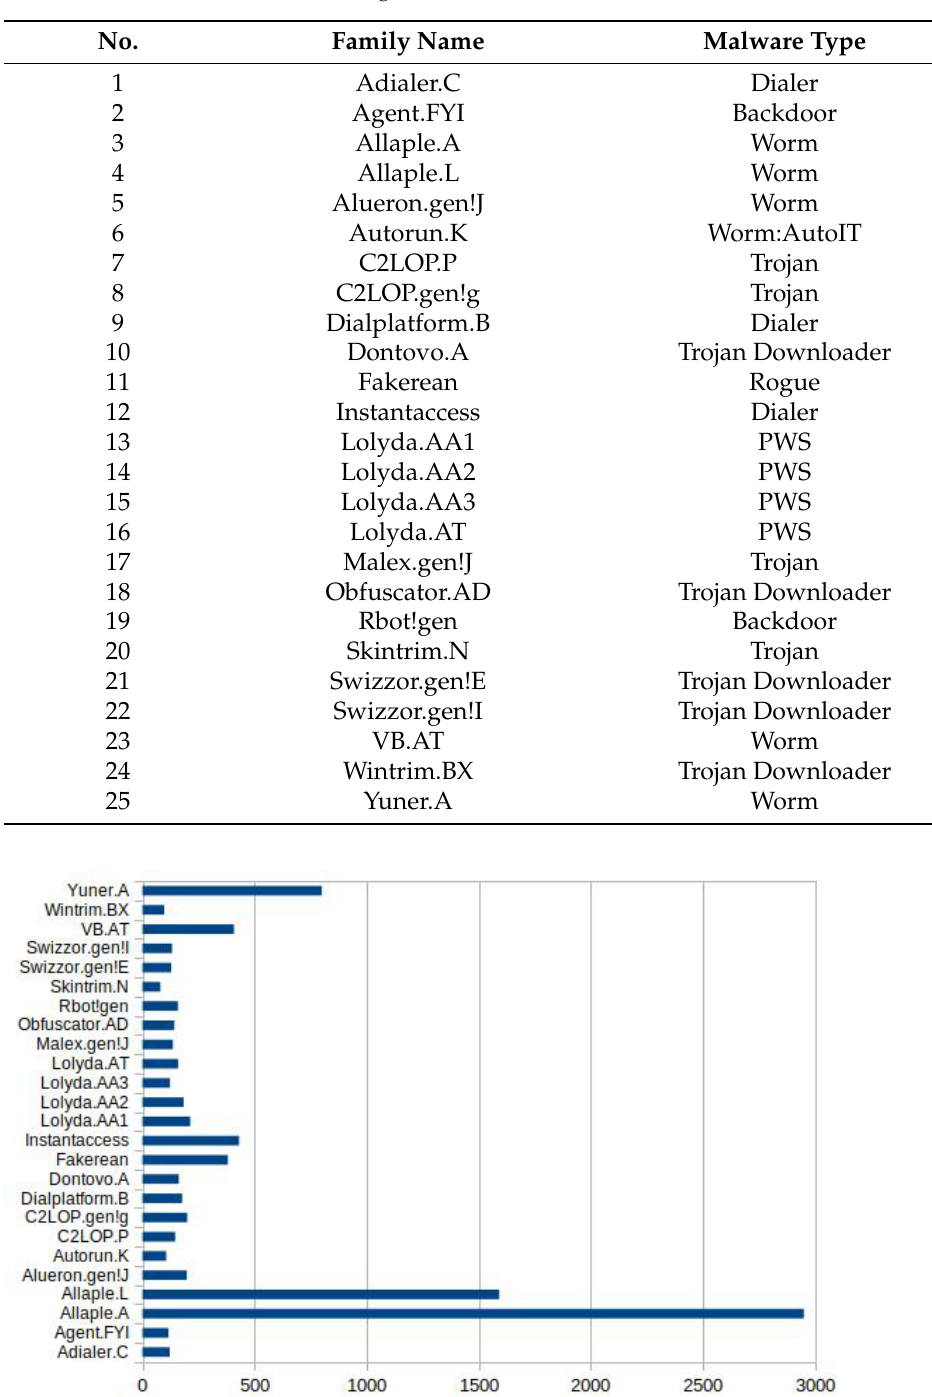
Table 1. Information about the Malimg Dataset Families.